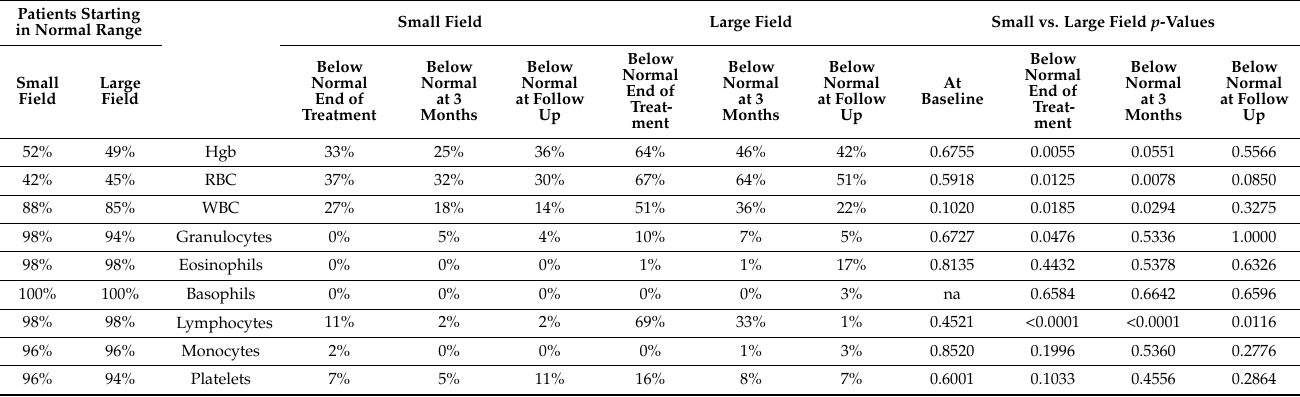
Table 5. Field size effect on patients starting in the normal